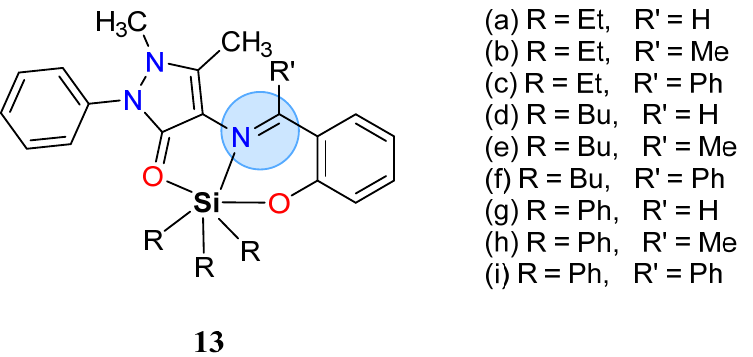
Figure 7. Silicon complex from a tridentate Schiff base ligand (ONO) with antimicrobial activity.